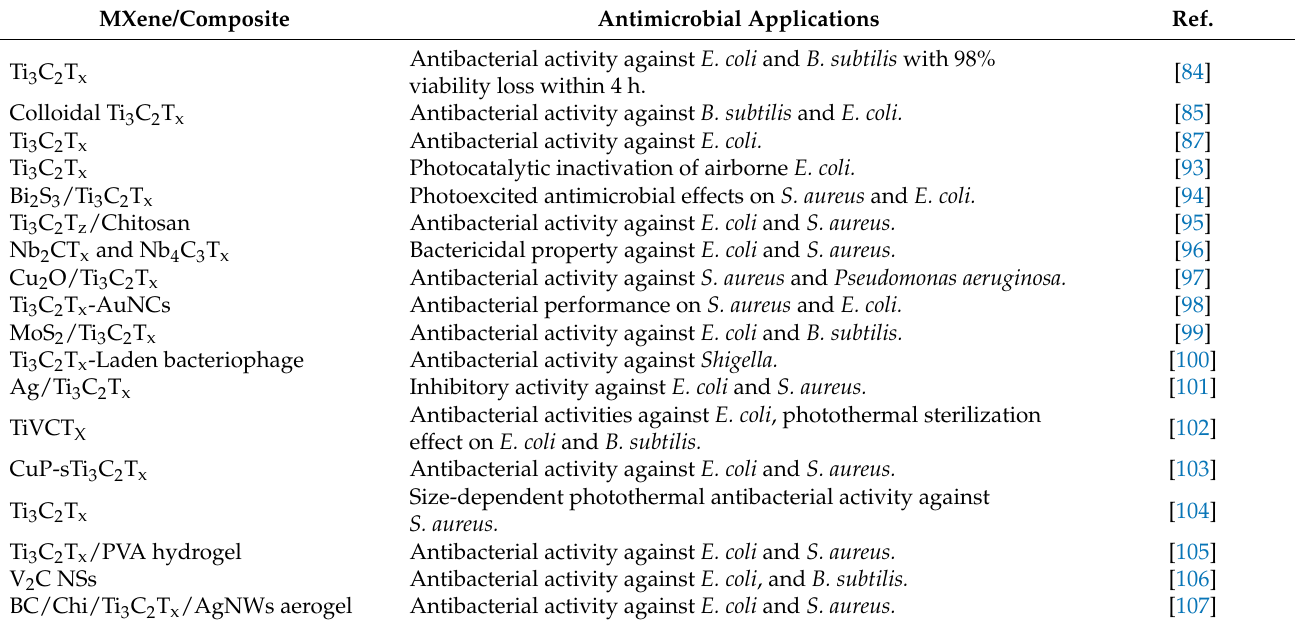
Table 3. Literature reports on the antimicrobial applications of MXene/Composites.